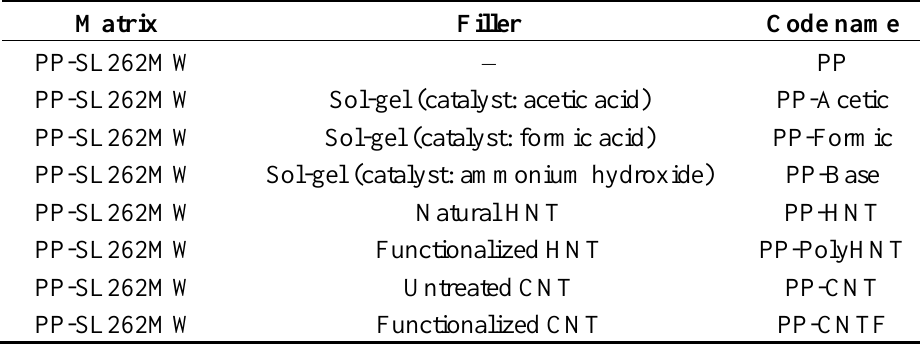
Table 2. Nomenclature for sample prepared in a 3-head